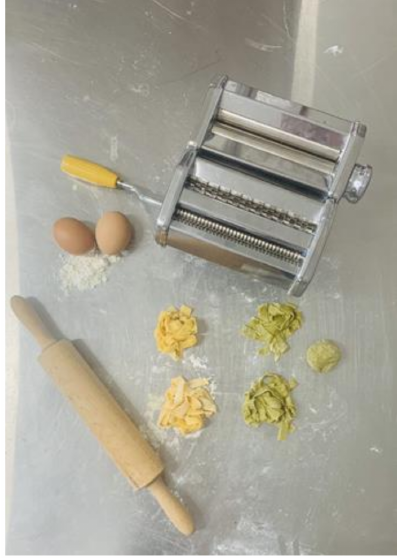
Figure 2. Ingredients and pasta